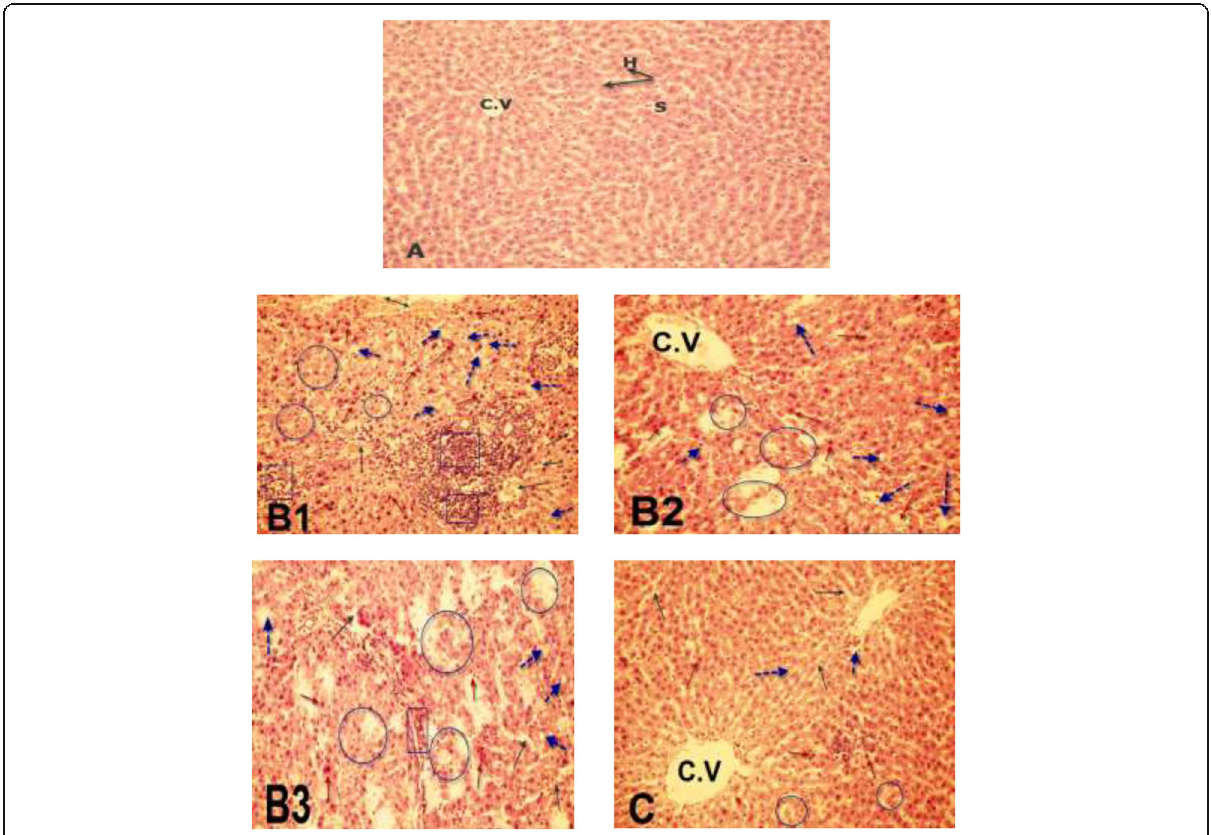
Fig. 1 Light micrographs of the liver tissues of rats treated as follow: liver tissue of control group ( A ) showing normal hepatocytes architecture, central vein (c.v), normal blood sinusoids (S), and hepatocytes (H). ( B1, B2, and B2 ) Liver tissue of triton-treated rats showing distended and hemorrhage in the central vein (C.V), loss of the normal hepatocytes architecture, degenerated hepatocytes and focal necrosis (circle), pyknotic nuclei (red arrows), heptacyte vacuolization (dotted blue arrows) and dilation and hemorrhage of hepatic sinusoids (black arrows) and lymphocytes aggregation, mononuclear cell infiltration (blue square). Histological alterations induced in triton + soybean oil-treated rats group ( C ) were markedly reduced. H&E stain. (×